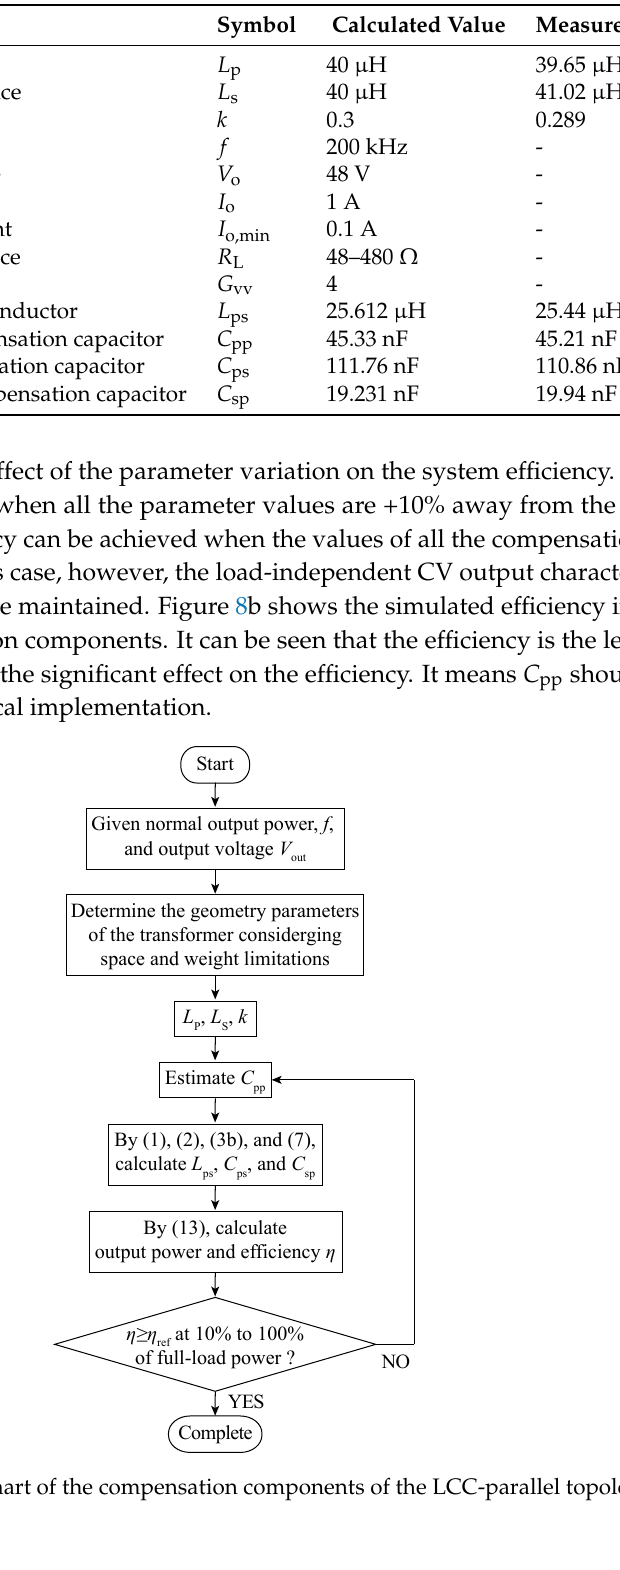
Table 1. System parameters of the LCC-parallel compensated IPT converter.